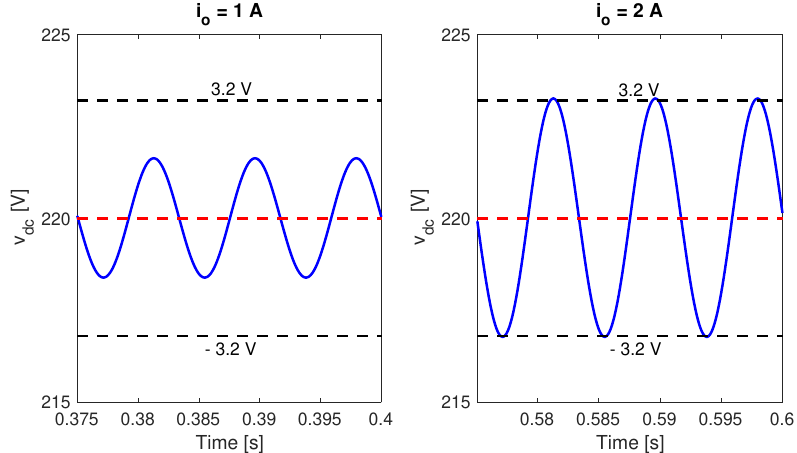
Figure 18. Validation of the low-frequency